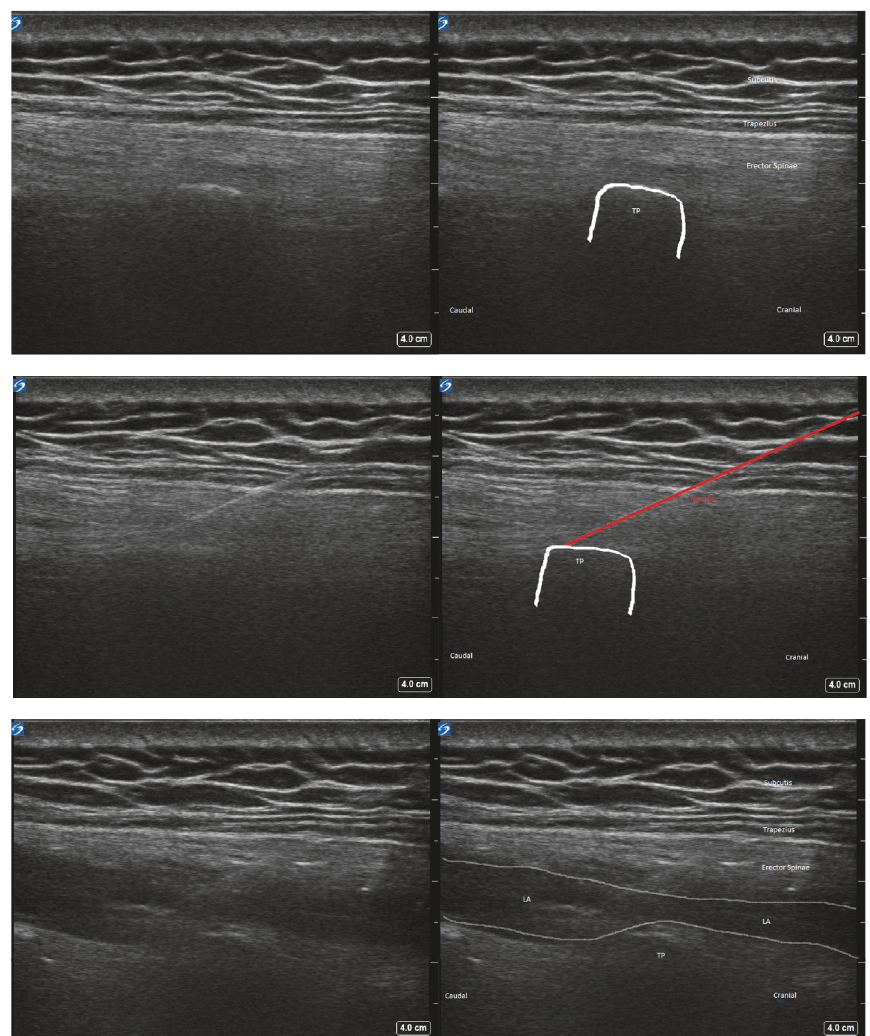
Figure 1: Ultrasound image showing subcutis, trapezius muscle, erector spinae muscle, transverse process of T7 (TP), needle path (in red), and spread of local anesthetic